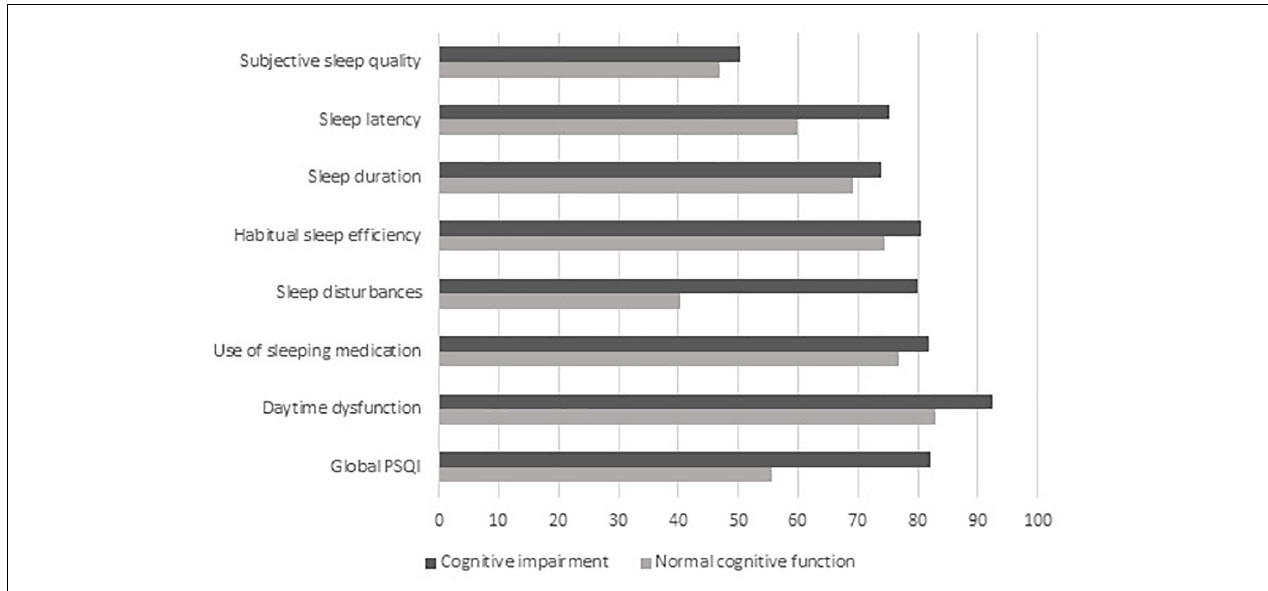
FIGURE 1 | Proportion of a score of > 5 on global and a score of 3 on each specific PSQI in HD patients with or without CI. PSQI, the Pittsburgh Sleep Quality Index; HD, hemodialysis; CI, cognitive impairment. TABLE 3 | Logistic regression for the association between overall and specific sleep disorders (global and specific PSQI scores) with cognitive impairment. Variables Crude Adjusted OR (95%CI) p